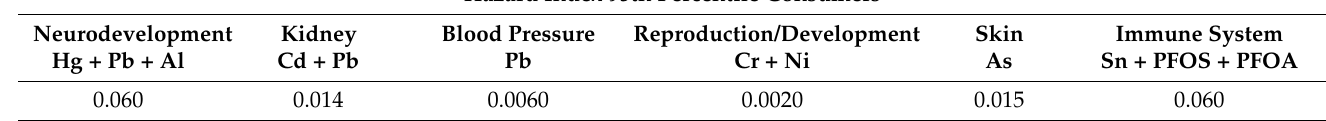
Table 10. Hazard indexes for the estimated daily exposure to the studied elements via preserved anchovies of the 95th percentile fish consumers, accounting for the highest concentrations